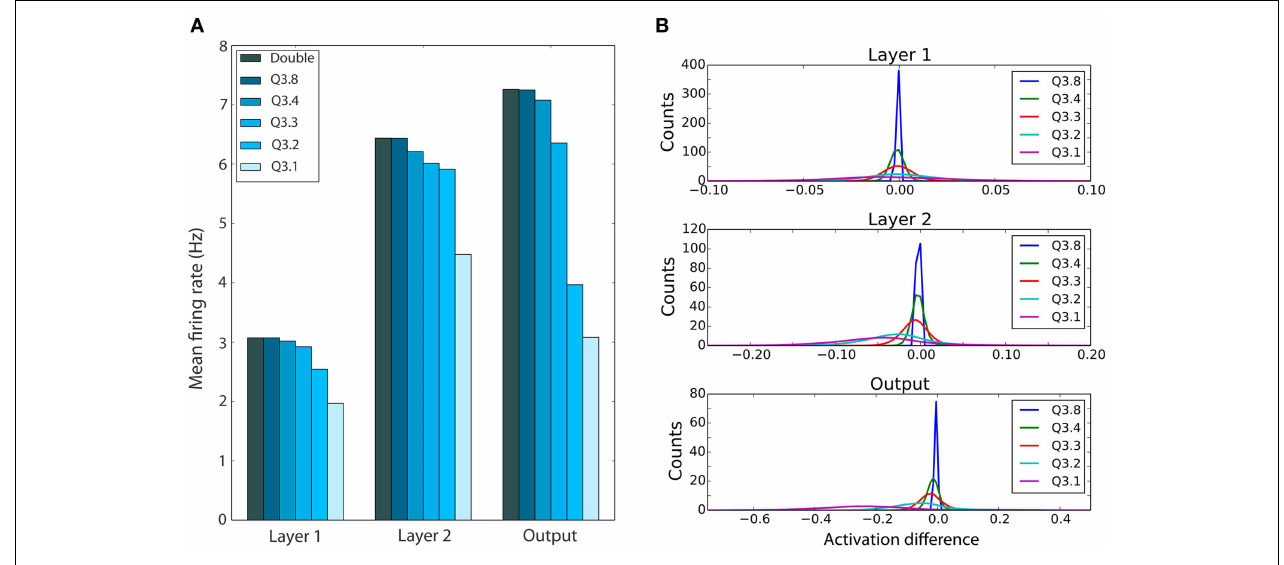
FIGURE 6 | Effect of reduced bit precision on firing rates in the DBN and neuron activations. (A) Mean firing rate of each layer of the network for weights with different bit precisions, using an input rate of 1500Hz. Lower precision levels, which lead to more weights at zero, cause lower firing rates within the network. (B) Distribution of the mean